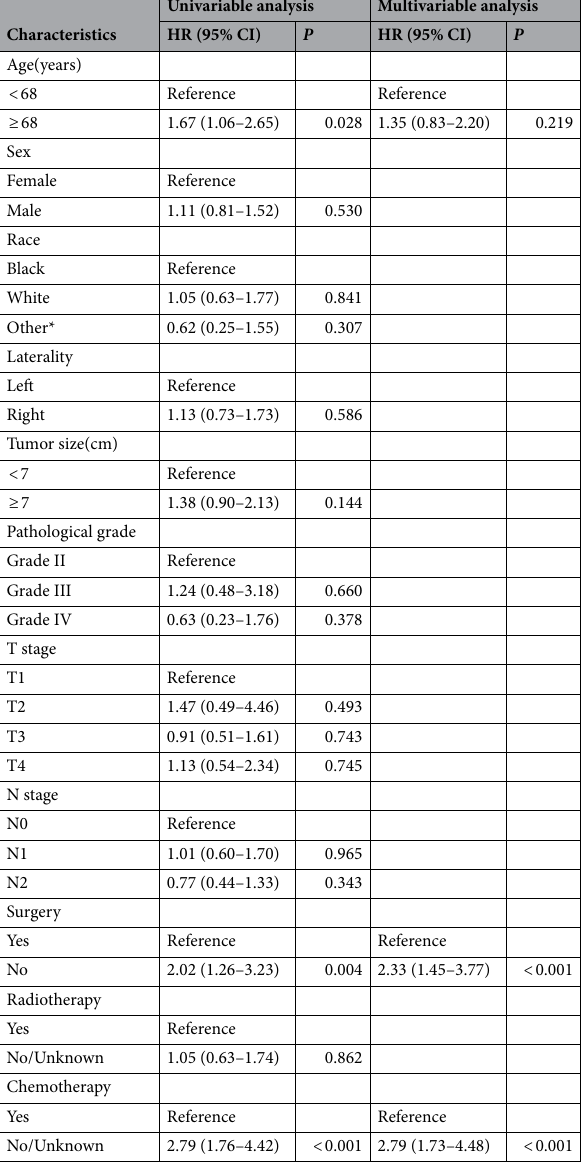
Table 2. Univariate and Multivariate Cox Regression Analysis of the Associations between Clinicopathological Features and OS in Patients with Metastatic CDC. CDC, renal collecting duct carcinoma; CI, confidence interval; HR, hazard ratio; OS, overall survival. *Other included American Indian/Alaskan Native and Asian/Pacific